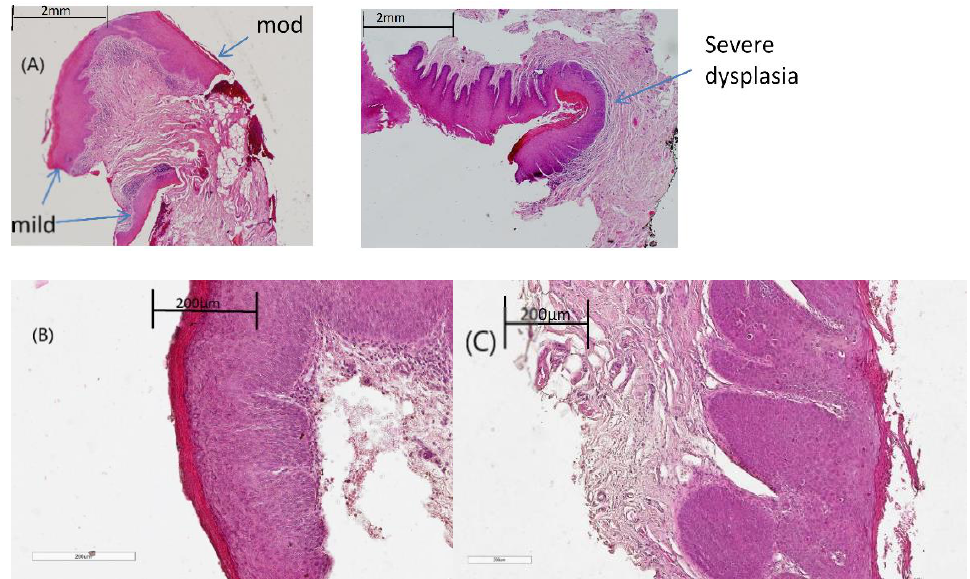
Figure 5. Representative H & E images showing ( A ) the regions of dysplasia marked by the pathologist. ( B ) A magnified region of moderate dysplasia ( C ) A magnified region of severe dysplasia. Scale bar: 200 µm.